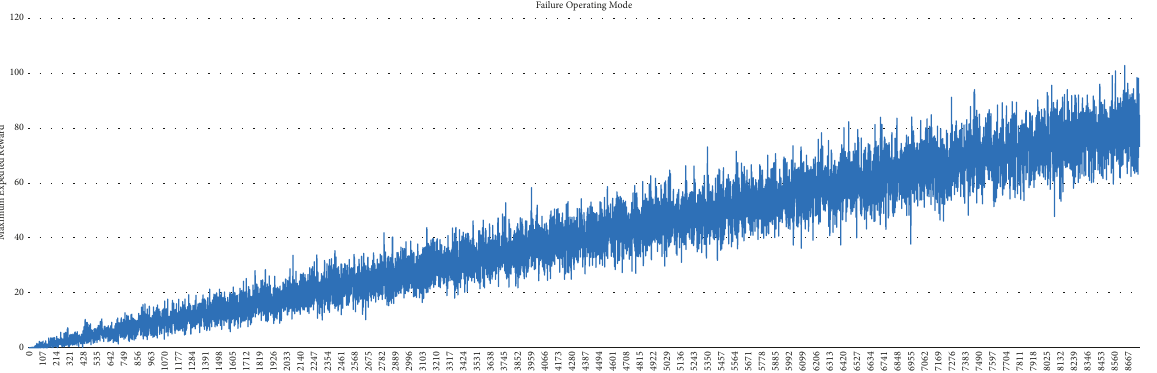
Figure 8: Maximum expected reward obtained for the failure operation mode of the IPR in one year of